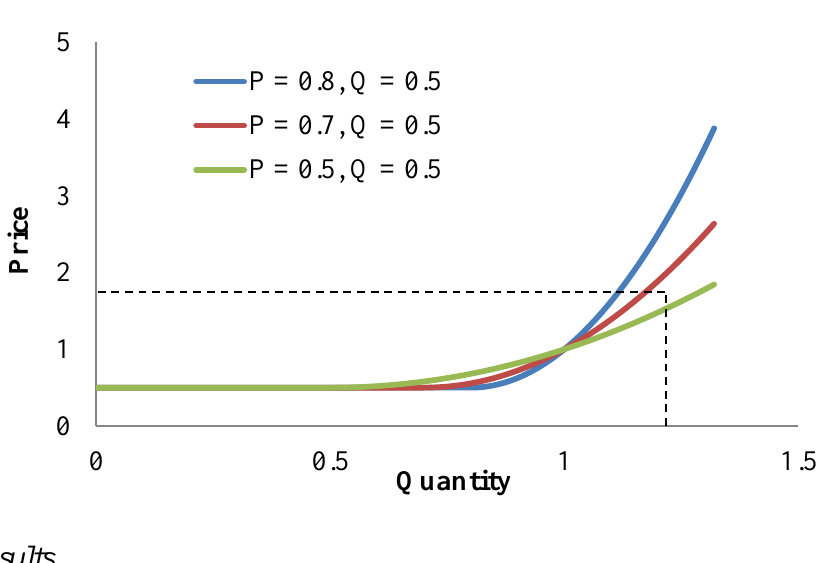
Figure 5. The individual supply curve with different